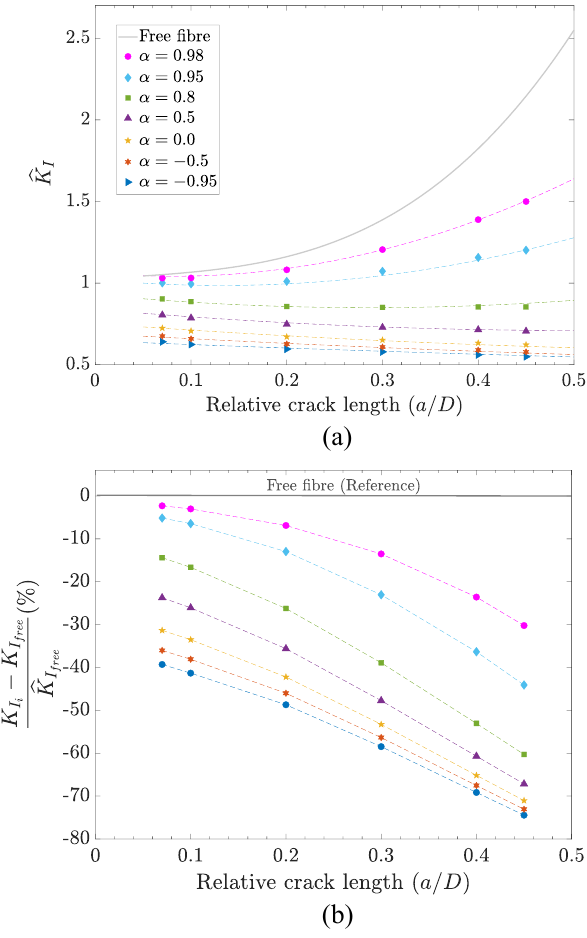
Figure 4. ( a ) Non-dimensional SIF for an isotropic fibre embedded in a matrix for different fibre– matrix stiffness ratios, α . The dots refer to the FEM results and the dashed lines to the fitting curves according to Equation (10). The continuous grey curve corresponds to the SIF for a free fibre ( α = 1). ( b ) Relative reduction of the non-dimensional SIF for an isotropic fibre embedded in a matrix with respect to the free fibre (continuous grey line).